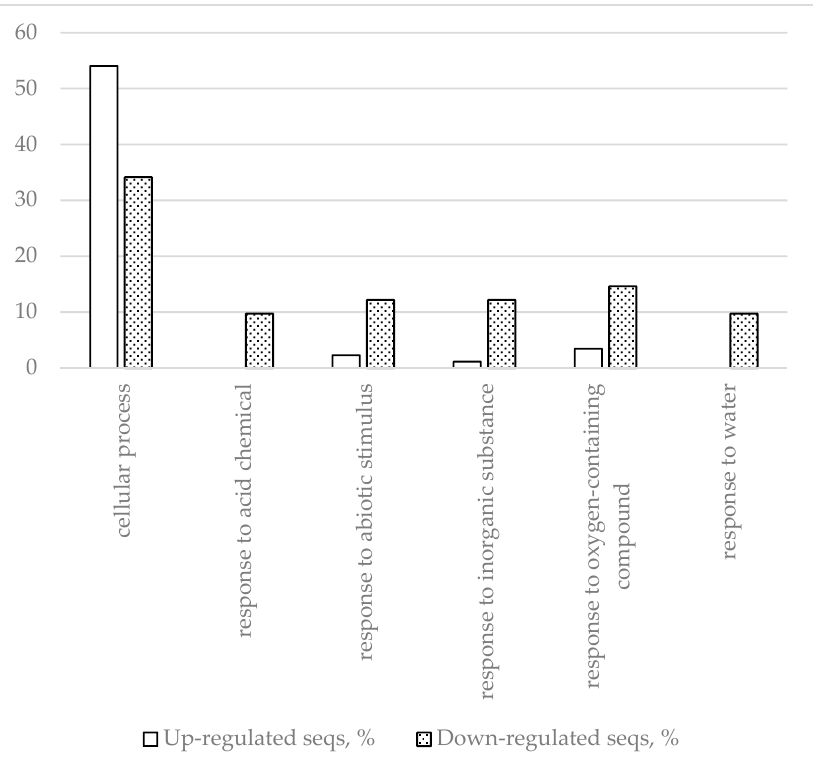
Table 10. Comparison of most frequent simplified DEG descriptions between the up- and down- regulated parts of the overlapping inoculation and wounding induced response (total number of upregulated DEGs = 87, downregulated DEGs = 41).